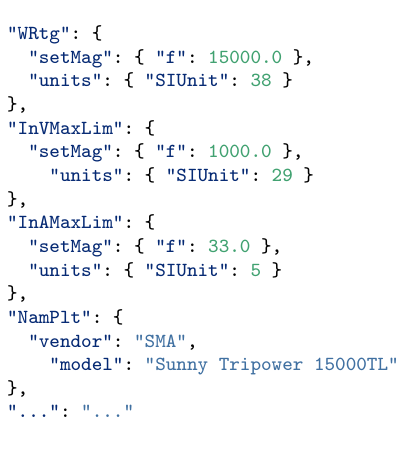
Listing 2. Excerpt of the Power Inverter’s Master Data using IEC 61850’s DINV